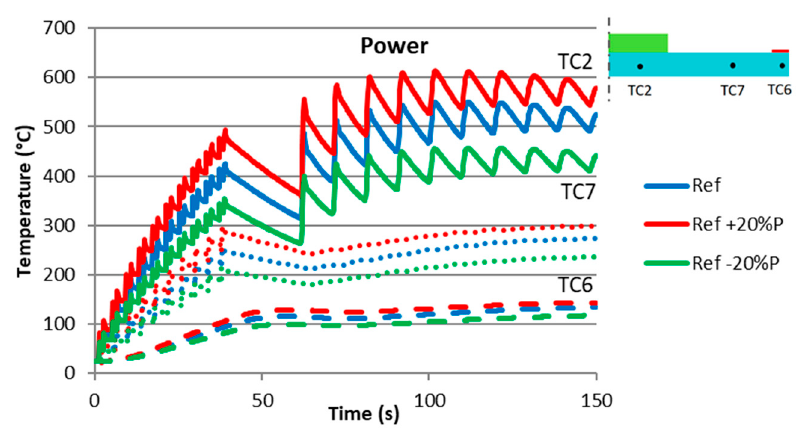
Figure 17. Effect of 20% positive and negative laser power variations on the computed thermal history at the local substrate measurement points TC2, TC6, and TC7.